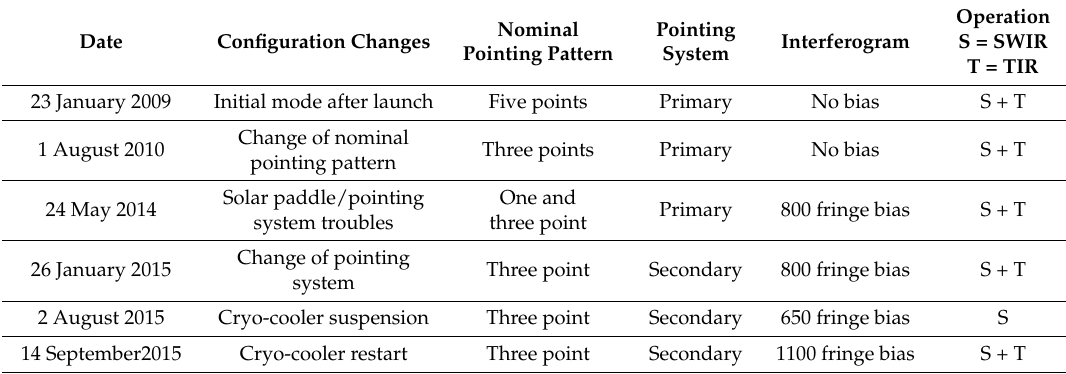
Table 1. Long-term operation status of